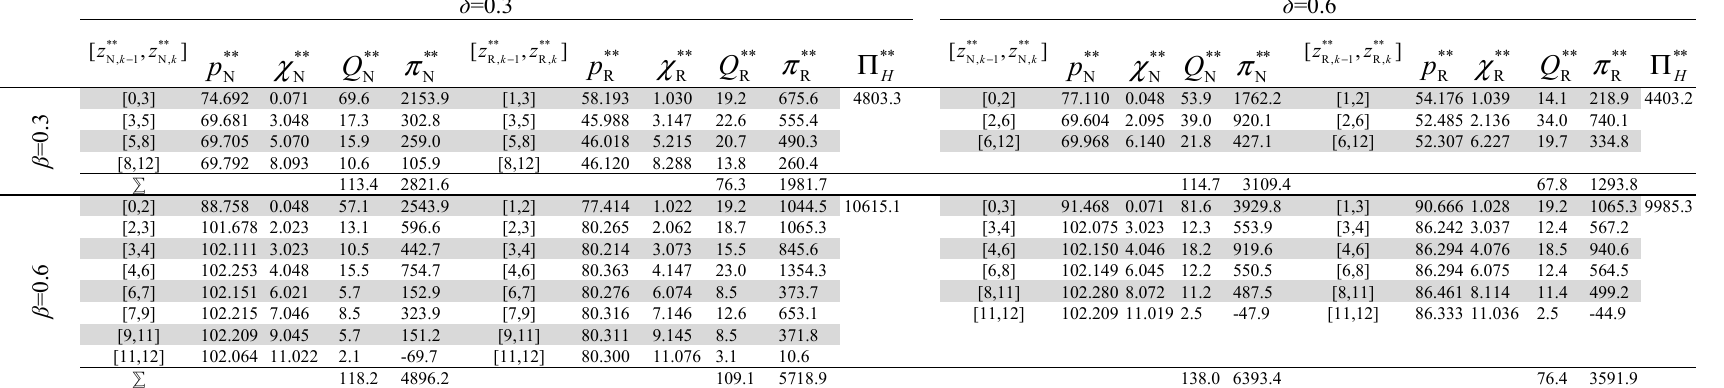
Joint decisions and profits of the hybrid remanufacturing EM setting (policy 4) under representative